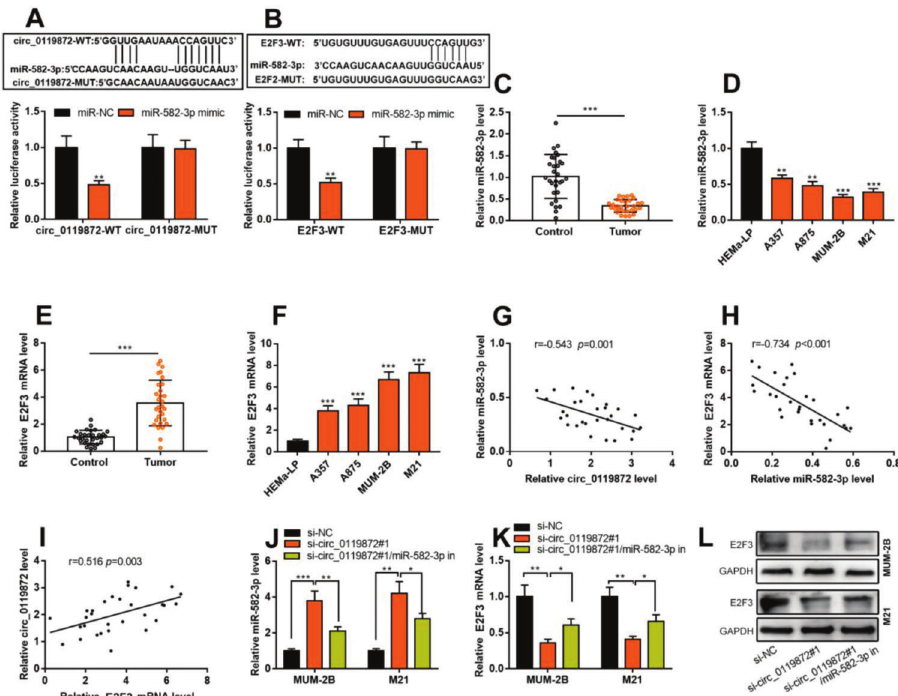
Figure 3 - Circ_0119872 modulates the expression of E2F transcription factor 3 (E2F3) through miR-582-3p. (A,B) Bioinformatics analysis and dual-luciferase reporter assay confirmed the direct binding relationship between circ_0119872 and miR-582-3p as well as that between miR-582-3p and E2F3 mRNA 3 0 -untranslated region (UTR). (C) MiR-582-3p expression in 30 pairs of MM and normal skin tissues was examined by qRT-PCR. (D) qRT-PCR was conducted to examine miR-582-3p expression in normal human epidermal melanocytes and MM cell lines (A357, A875, MUM-2B, and M21). (E) E2F3 expression in 30 pairs of MM and normal skin tissues was examined by qRT-PCR. (F) qRT-PCR was performed to examine E2F3 expression in normal human epidermal melanocytes and melanoma cell lines (A357, A875, MUM-2B, and M21). (G–I) Pearson correlation analysis was performed to analyze the correlation between circ_0119872, miR-582-3p, and E2F3 expression levels in MM tissues. (J) MiR-582-3p expression in MUM-2B and M21 cell lines was detected by qRT-PCR after co-transfection with si-circ_0119872 #1 and miR-582-3p inhibitors. (K,L) qRT-PCR and western blotting were conducted to detect E2F3 expression in MUM-2B and M21 cell lines after co-transfection with si-circ_0119872#1 and miR-582-3p inhibitors. * p o 0.05, ** p o 0.01, and *** p o